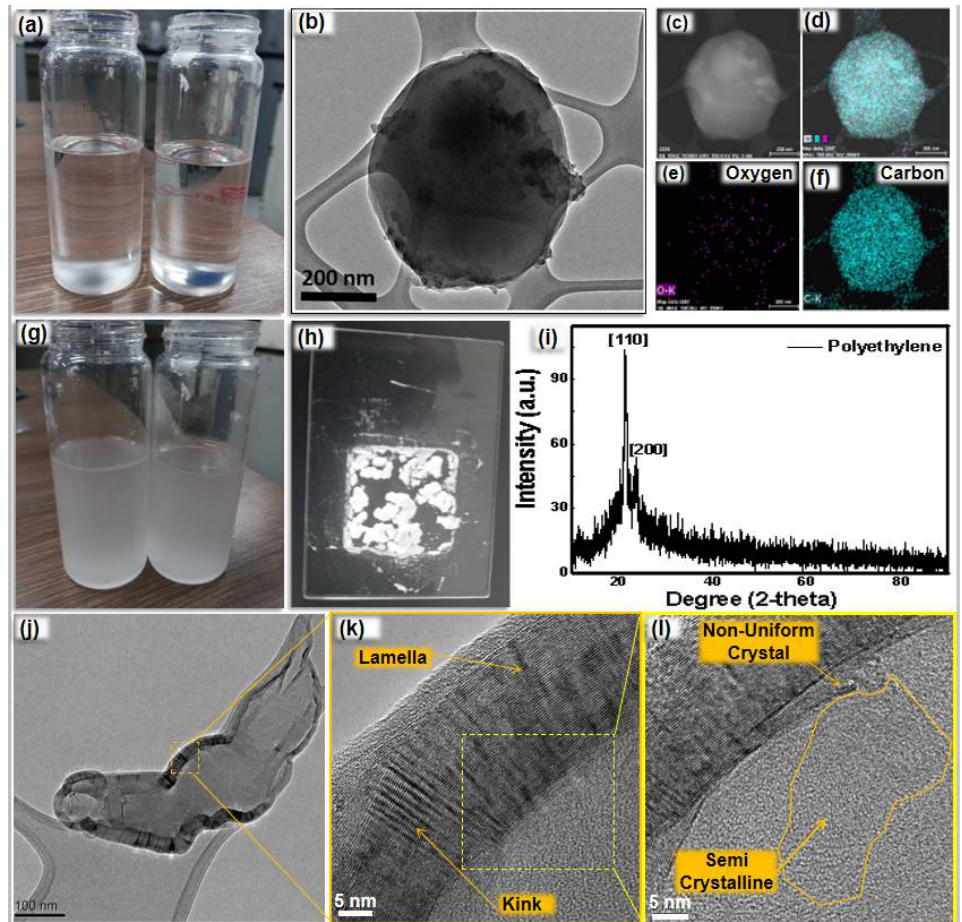
Figure 2. ( a ) Solution of PE in toluene at 105 °C; ( b ) TEM and ( c – f ) TEM-EDS of PE particles; ( g ) PE in toluene at room temperature; ( h ) semi-crystalline PE powder after removal of solvent; ( i ) XRD patterns, ( j ) TEM and ( k,l ) HRTEM of semi-crystalline PE.